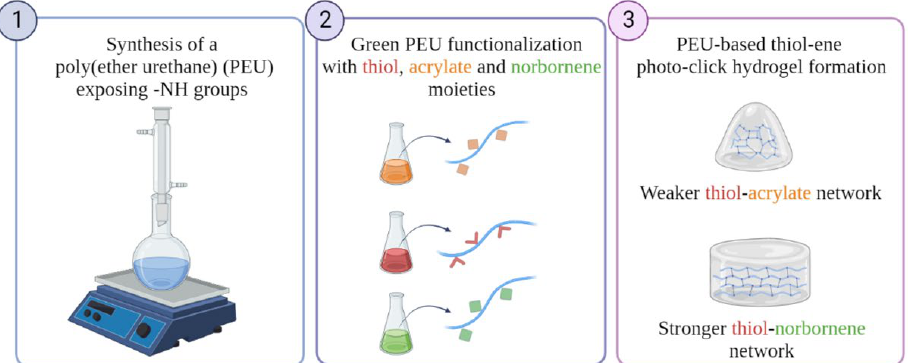
Figure 1. Schematic representation of the concept underpinning the work: (1) synthesis of an amphiphilic poly(ether urethane) bearing secondary amino groups; (2) polymer functionalization with different photo-sensitive moieties by exploiting the water-based carbodiimide chemistry, and (3) formulation of thiol-ene photo-click hydrogels characterized by a double network formed as a consequence of temperature increase followed by exposure to visible light, and a different strength based on the -ene moiety.